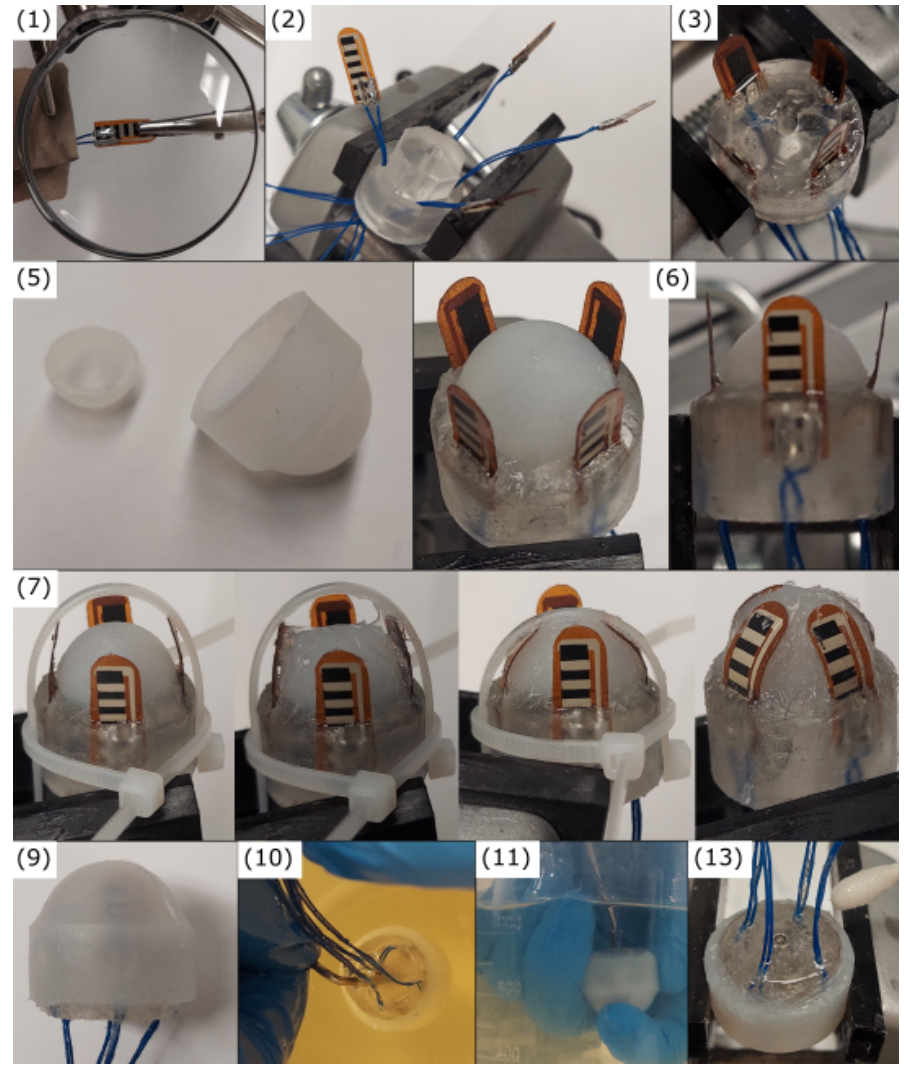
Figure 5. Sensor fabrication process; numbered photos correspond to the listed fabrication